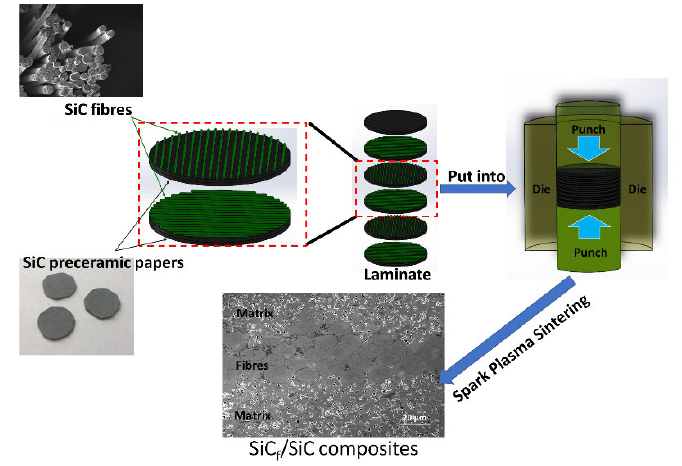
Figure 1. Schematic diagram of the fabrication process of the preceramic paper-derived SiC f /SiC composites.